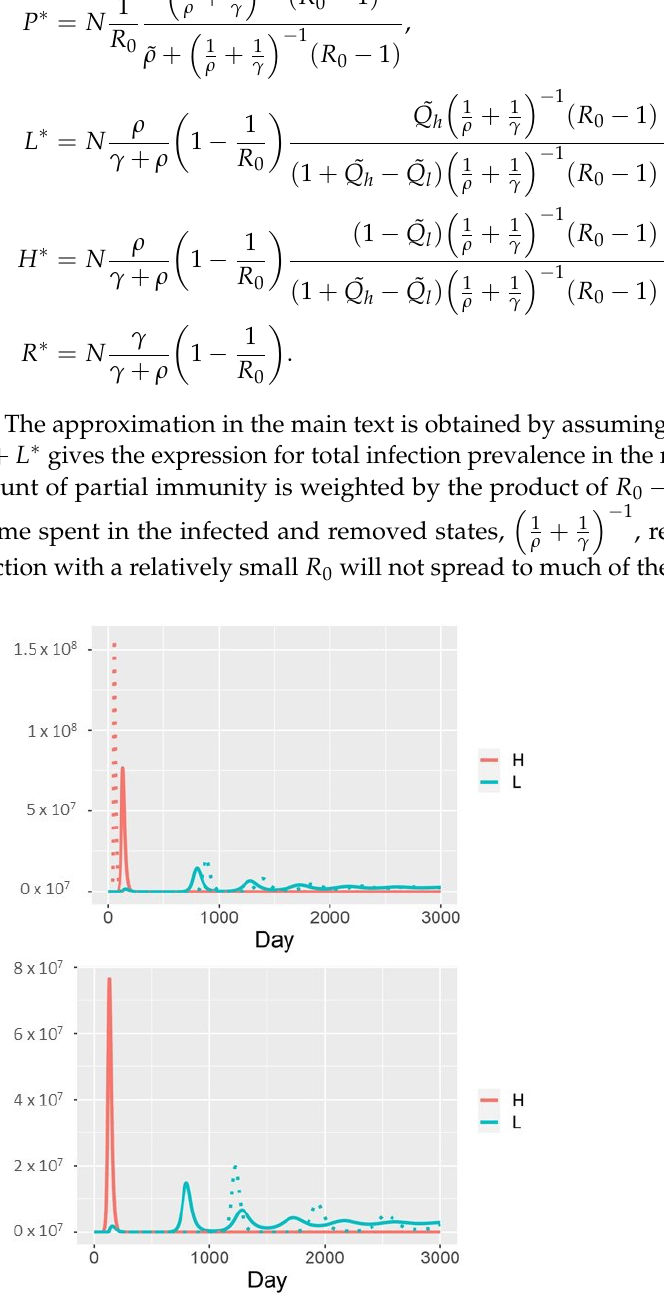
Figure A1. Accounting for infectiousness θ and susceptibility ˜ ν in the model with two infection phenotypes If high-shedding individuals are twice as infectious, the initial outbreak is larger, consists of fewer low-shedding cases, and the subsequent outbreak of low-shedding cases occurs later (dotted curve: θ = 2, solid curve: θ = 1, ( top panel )). If partially immune individuals are half as susceptible, it takes longer to reach the endemic steady state because subsequent outbreaks occur later (dotted curves: ˜ ν = 1/2, solid curves: ˜ ν = 1, ( bottom panel ); all other parameters as in Figure